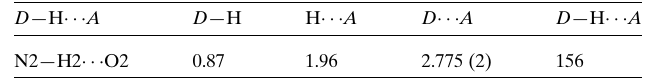
Table 1 Hydrogen-bond geometry (A˚ , (cid:5)